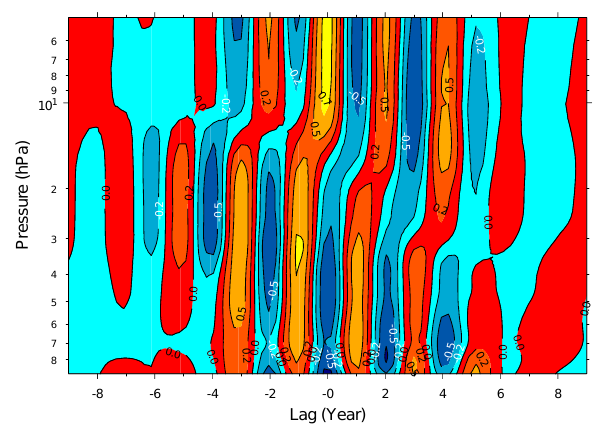
Fig. 4. The time-lagged cross-covariance between the summer mesospheric temperatures and each level of the QBO wind from 90 to 5hPa. Blue denotes negative (anti-correlation) and red denotes positive